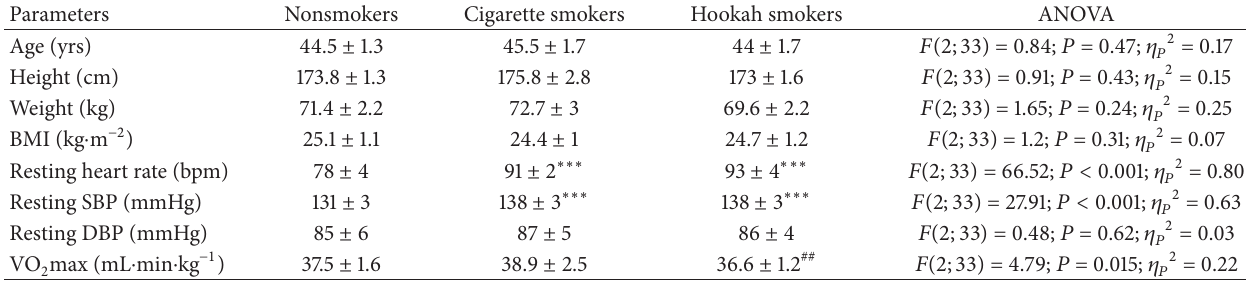
Table 1: Anthropometric and physical characteristics of participants (mean ±